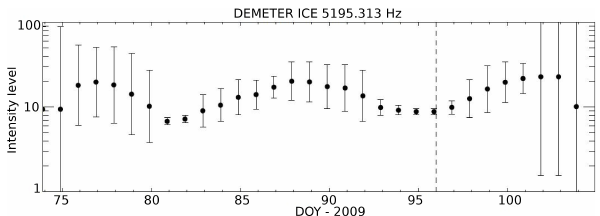
Fig. 3. Variation of the whistlers VLF emissions observed daily above L’Aquila regions by ICE experiment on board DEMETER micro-satellite at a frequency of